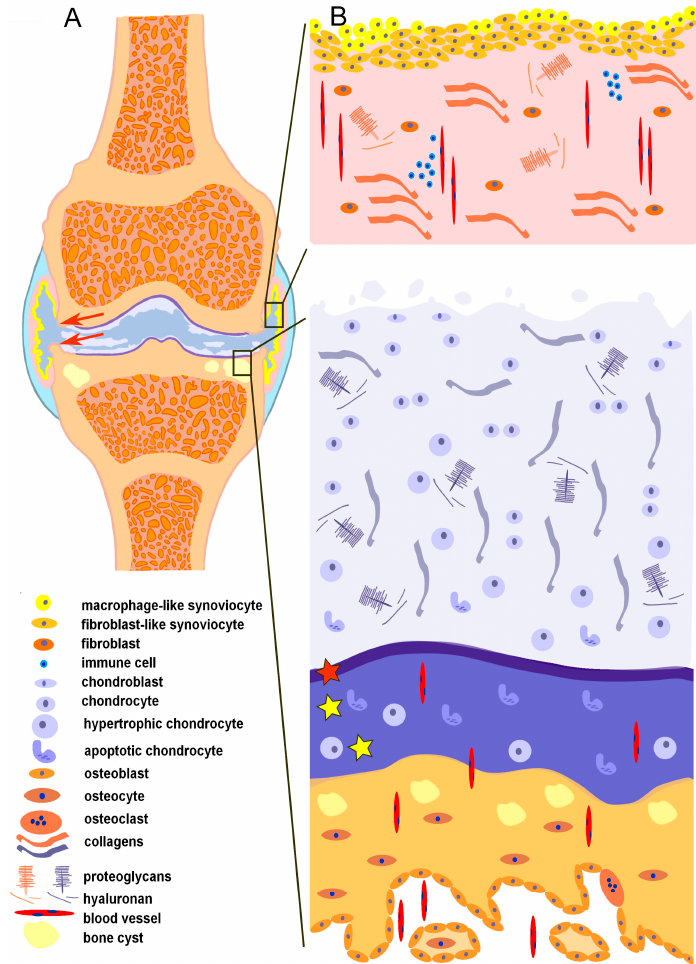
Figure 3. Schematic overview of the OA-affected synovial joint with involvement of both “chon- drosynovial” and “osteochondral units”. ( A ) Synovial joint depicting common changes, such as degradation of the articular cartilage, formation of subchondral bone cysts, and osteophytes (red arrows). ( B ) The synovial membrane (upper part) reveals hyperplasia of the lining layer, immune cell infiltration, angiogenesis, and fibrosis in the sublining layer. Alterations of the articular cartilage (lower part) include degradation of the non-calcified zone and thickening of the calcified zone (yellow asterisks), formation of free cartilage fragments, duplication of tidemark (red asterisk), alterations in the composition of cellular and extracellular matrix. Remodeling of the subchondral bone (lower part) reveals the thickening of the cortical bone plate, formation of cysts, and angiogenesis.